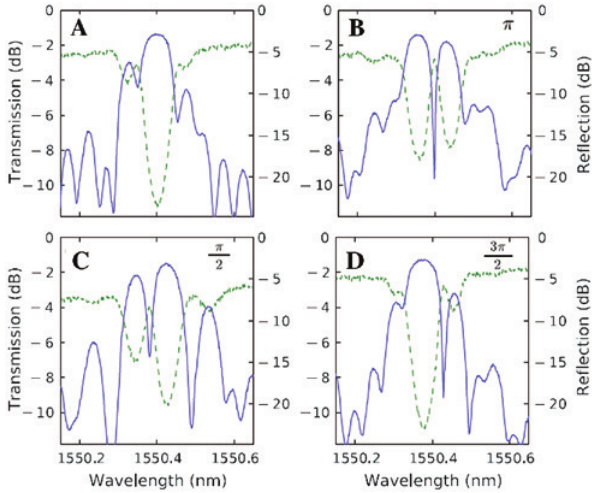
Figure 18: Vertically polarised transmission (dashed green curve) and reflection (solid blue curve) spectra for a fused silica WBG with (A) no phase shift, (B) π phase shift, (C) π /2 phase shift, and (D) 3 π /2 phase shift. Reprinted with permission from